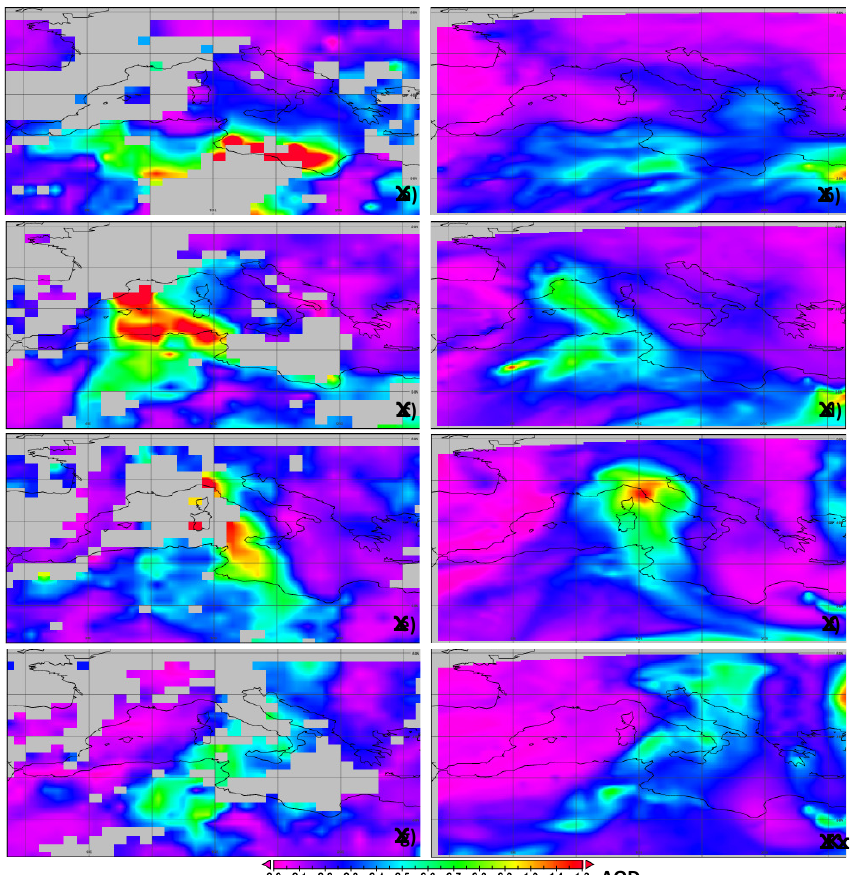
Figure 5. MODIS-Terra AOD at 550nm (combined Dark Target and Deep Blue algorithms) over land and ocean at 1 ◦ resolution as retrieved for (a) 20 May, (c) 21 May, (e) 22 May, and (g) 23 May, as well as model (S01) AOD distribution for (b) 20 May, (d) 21 May, (f) 22 May, and (h) 23 May, at